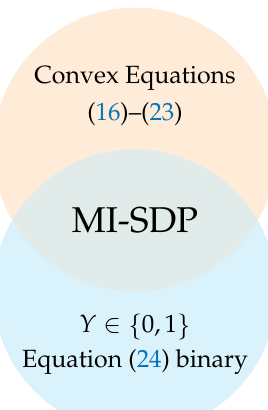
Figure 2. Equivalent MI-SDP model for the problem of the optimal location and sizing of distributed generators in DC distribution